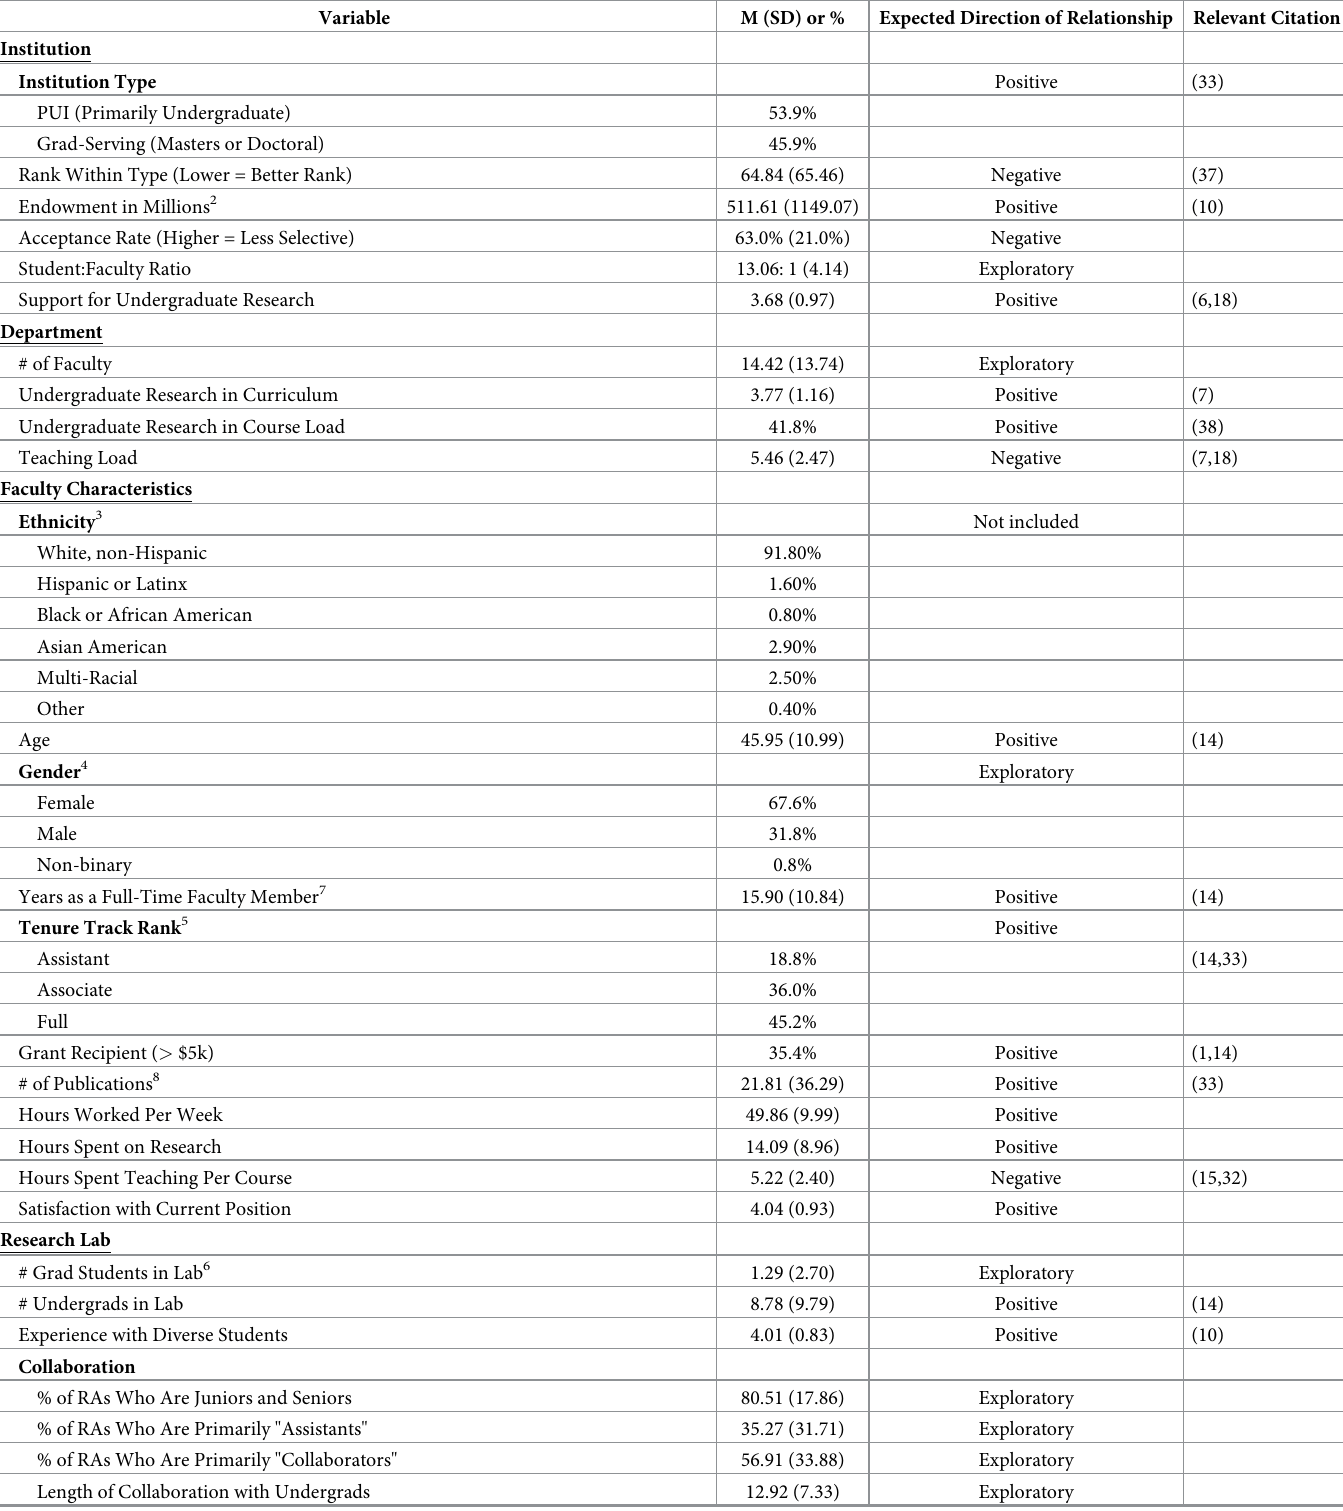
Table 1. List of variables, descriptive statistics, predicted relationship with number of undergraduate (UG) publications, and associated citations 1 .